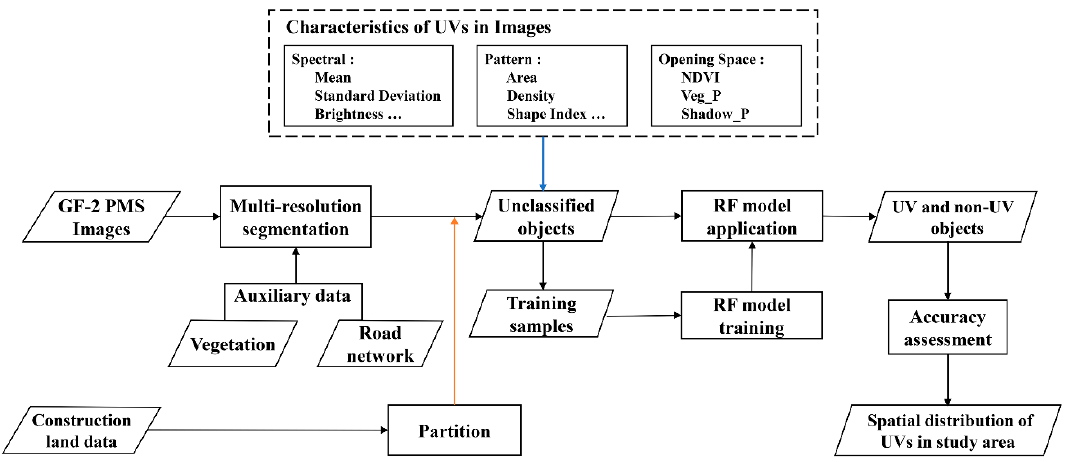
Figure 2. Flowchart of urban villages (UVs) detection.